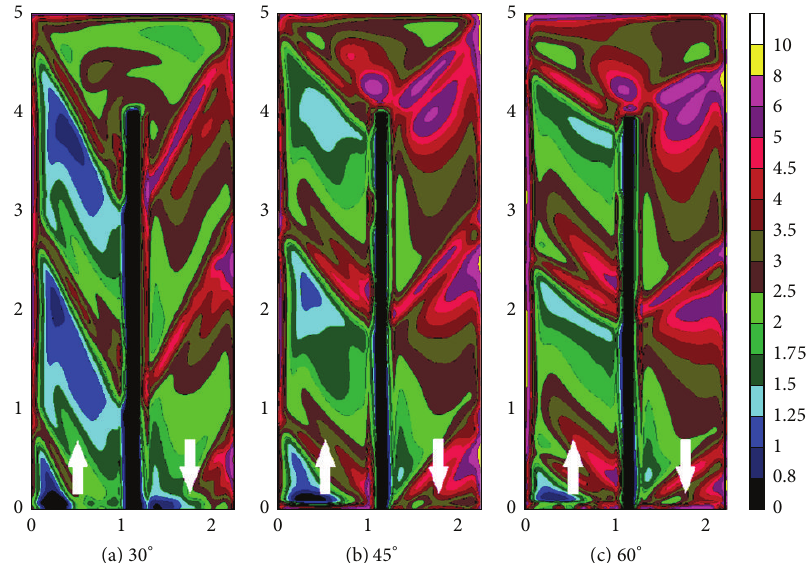
Figure 10: Nu / Nu ∗ distribution for a channel with superimposed ribs, Re = 30,000, 𝑝/𝑒 = 20 , and various rib angles 𝛿 ; adapted from Astarita et al.